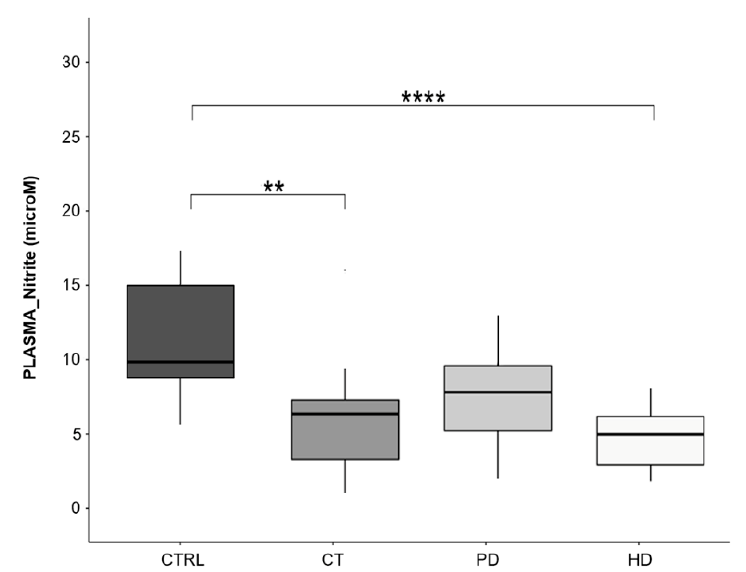
Figure 7. Plasma nitrite levels. Box plots represent plasma nitrite levels in the four study groups (CTRL, CT, PD, HD; N = 20 for each group). Nitrite concentration was determined spectrophotometrically and expressed as micromolar (microM). Horizontal black lines indicate the medians, boxes the interquartile range (IQR) and the bottom and top whiskers represent the minimum and maximum values. (** p < 0.01; **** p < 0.0001).